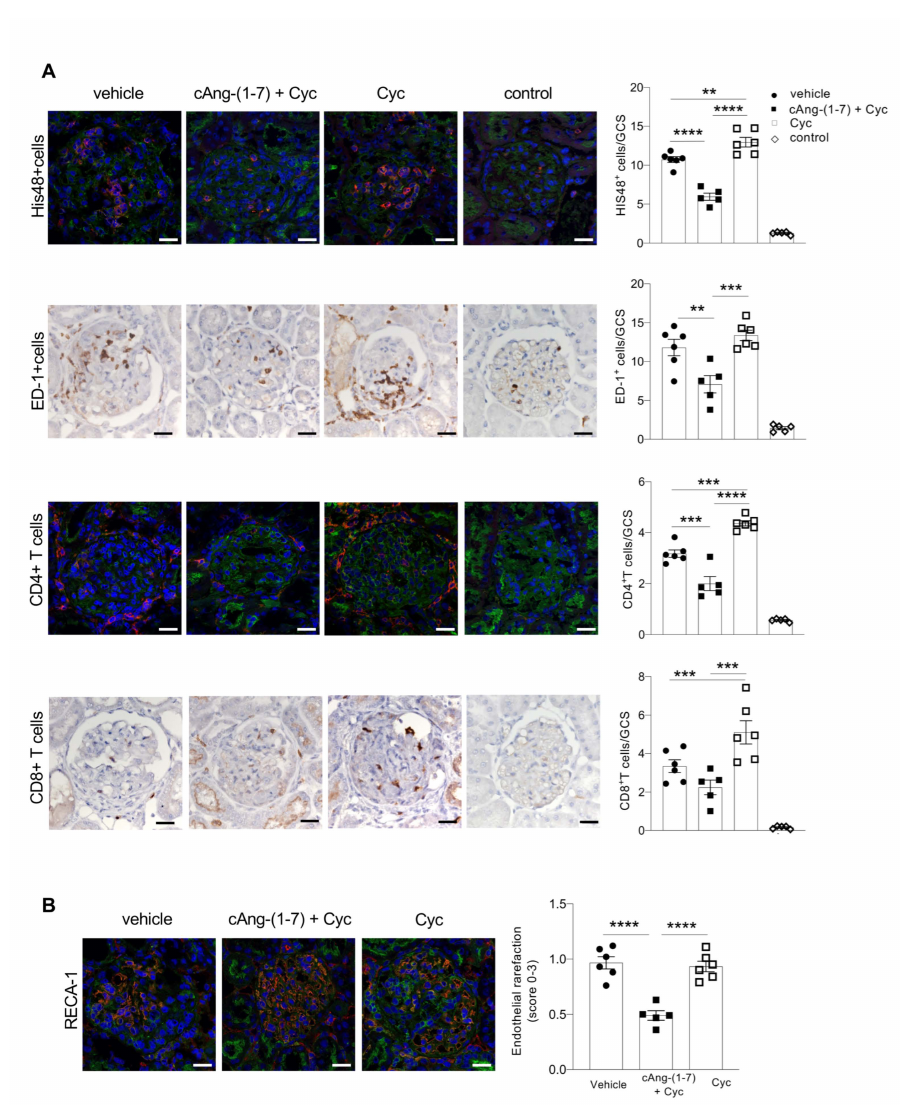
Figure 4. Addition of cAng-(1-7) to cyclophosphamide limits glomerular inflammation and endothe- lial rarefaction in rats with ANCA-GN. ( A ) Representative images and quantification of inflamma- tory/immune cells expressed as an average number of cells per glomerulus showing, respectively, HIS48 + granulocytes (red), ED1 + monocytes/macrophages (brown), CD4 + T cells (red), and CD8 + T cells (brown) in the glomeruli of WKY rats with ANCA-GN treated with vehicle, cAng-(1-7) plus cyclophosphamide or cyclophosphamide alone and WKY controls. Magnification: × 630; scale bar 25 µ m. ( B ) Representative images showing glomerular RECA-1 expression in WKY rats with ANCA-GN treated with vehicle, combined therapy, and cyclophosphamide alone. The distribution of RECA-1 staining of capillaries in the glomerular tuft was scored as follows: 0, normal density of capillaries; 1+, reduced capillary density in <25% of tuft; 2+, reduced capillary density in 25%–50% of the tuft; and 3+, reduced capillary density in >50% of the tuft. Data are mean ± SEM. ** p <